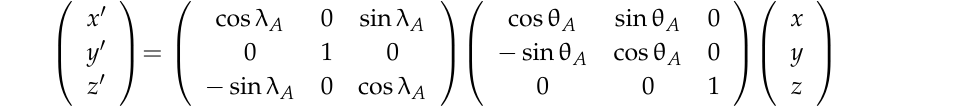
Figure 4. Direction of symmetry axis.